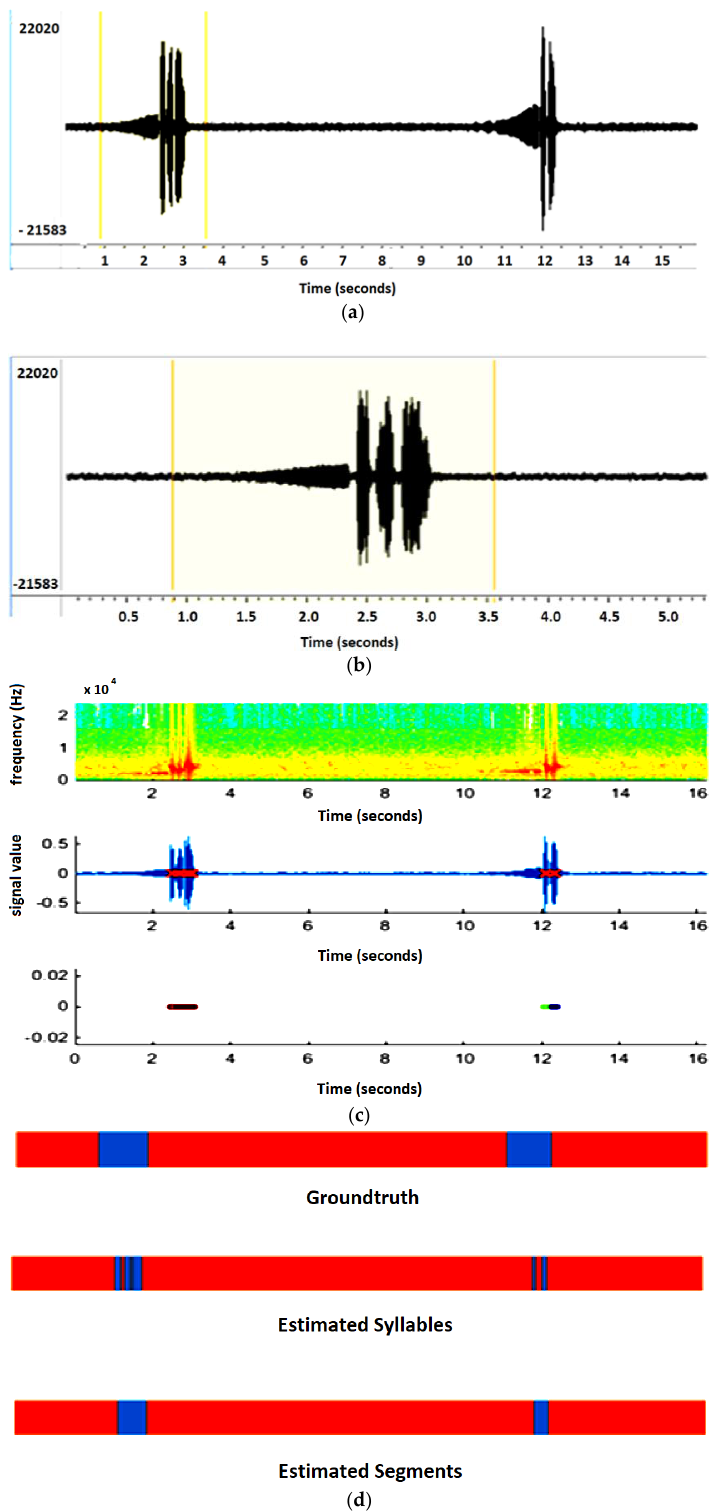
Figure 3. Performance analysis of segmentation algorithms for the monosyllabic bird (Tickell’s Leaf Warbler). ( a ) Syllables’ sequence of monosyllabic bird; ( b ) Zoomed view of first sequence of syllable for monosyllabic bird; ( c ) Results of segmentation with proposed approach; ( d ) Compari- son of proposed approach with ground truth.